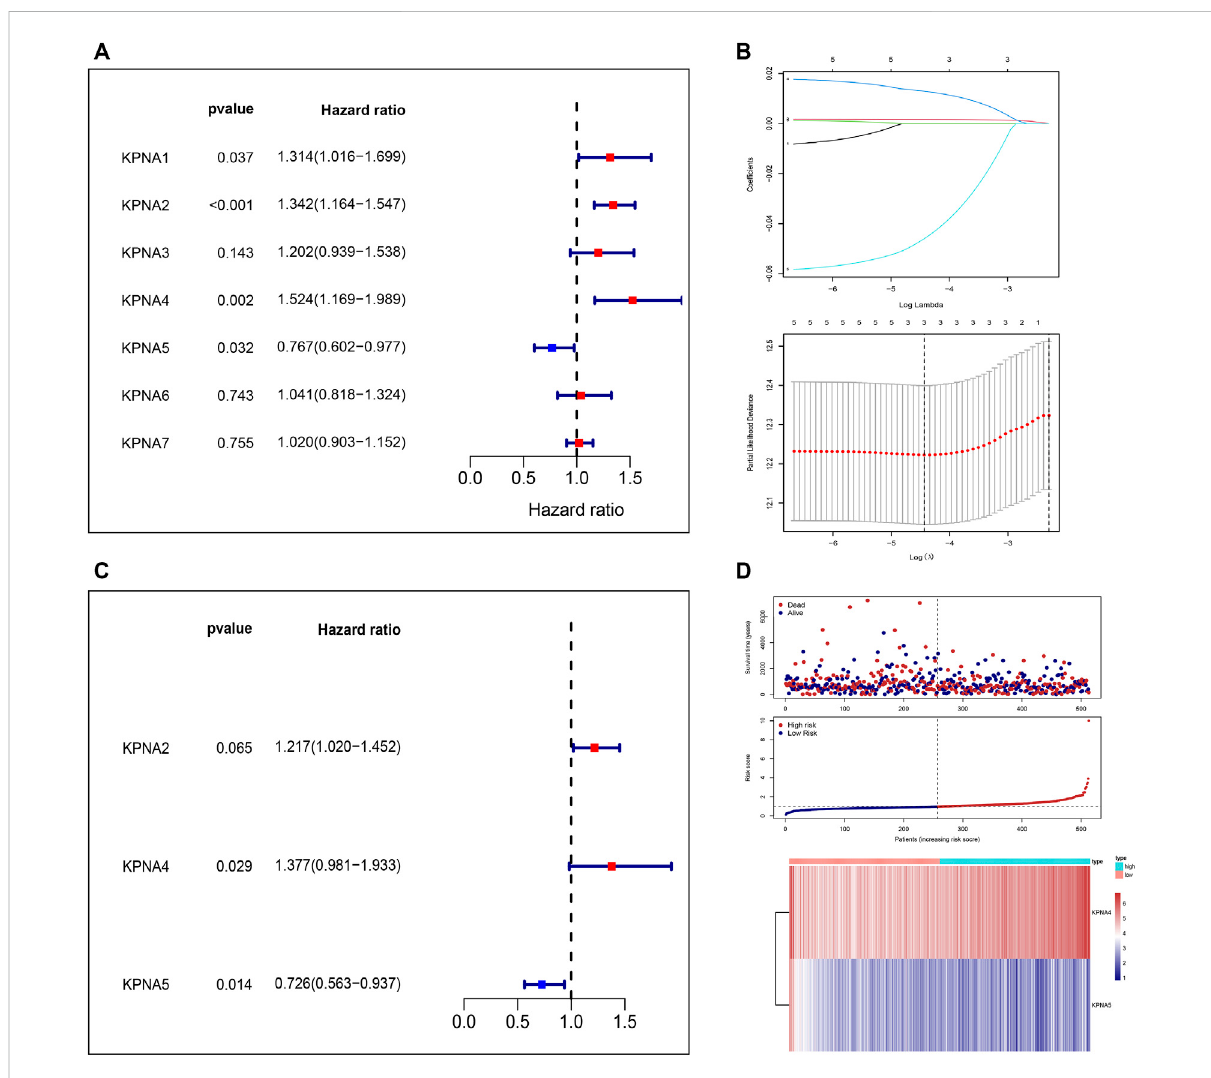
FIGURE 3 Independent prognostic factors of the KPNA family (A) Forest plot of univariate Cox regression analysis of the KPNA family (B) Lasso regression modeloftheKPNAfamily (C) ForestplotofmultivariateCoxregressionanalysisoftheKPNAfamily (D) Calculated riskscoreandtheheatmapsofrisk factors based on the fi ndings of multivariate Cox regression